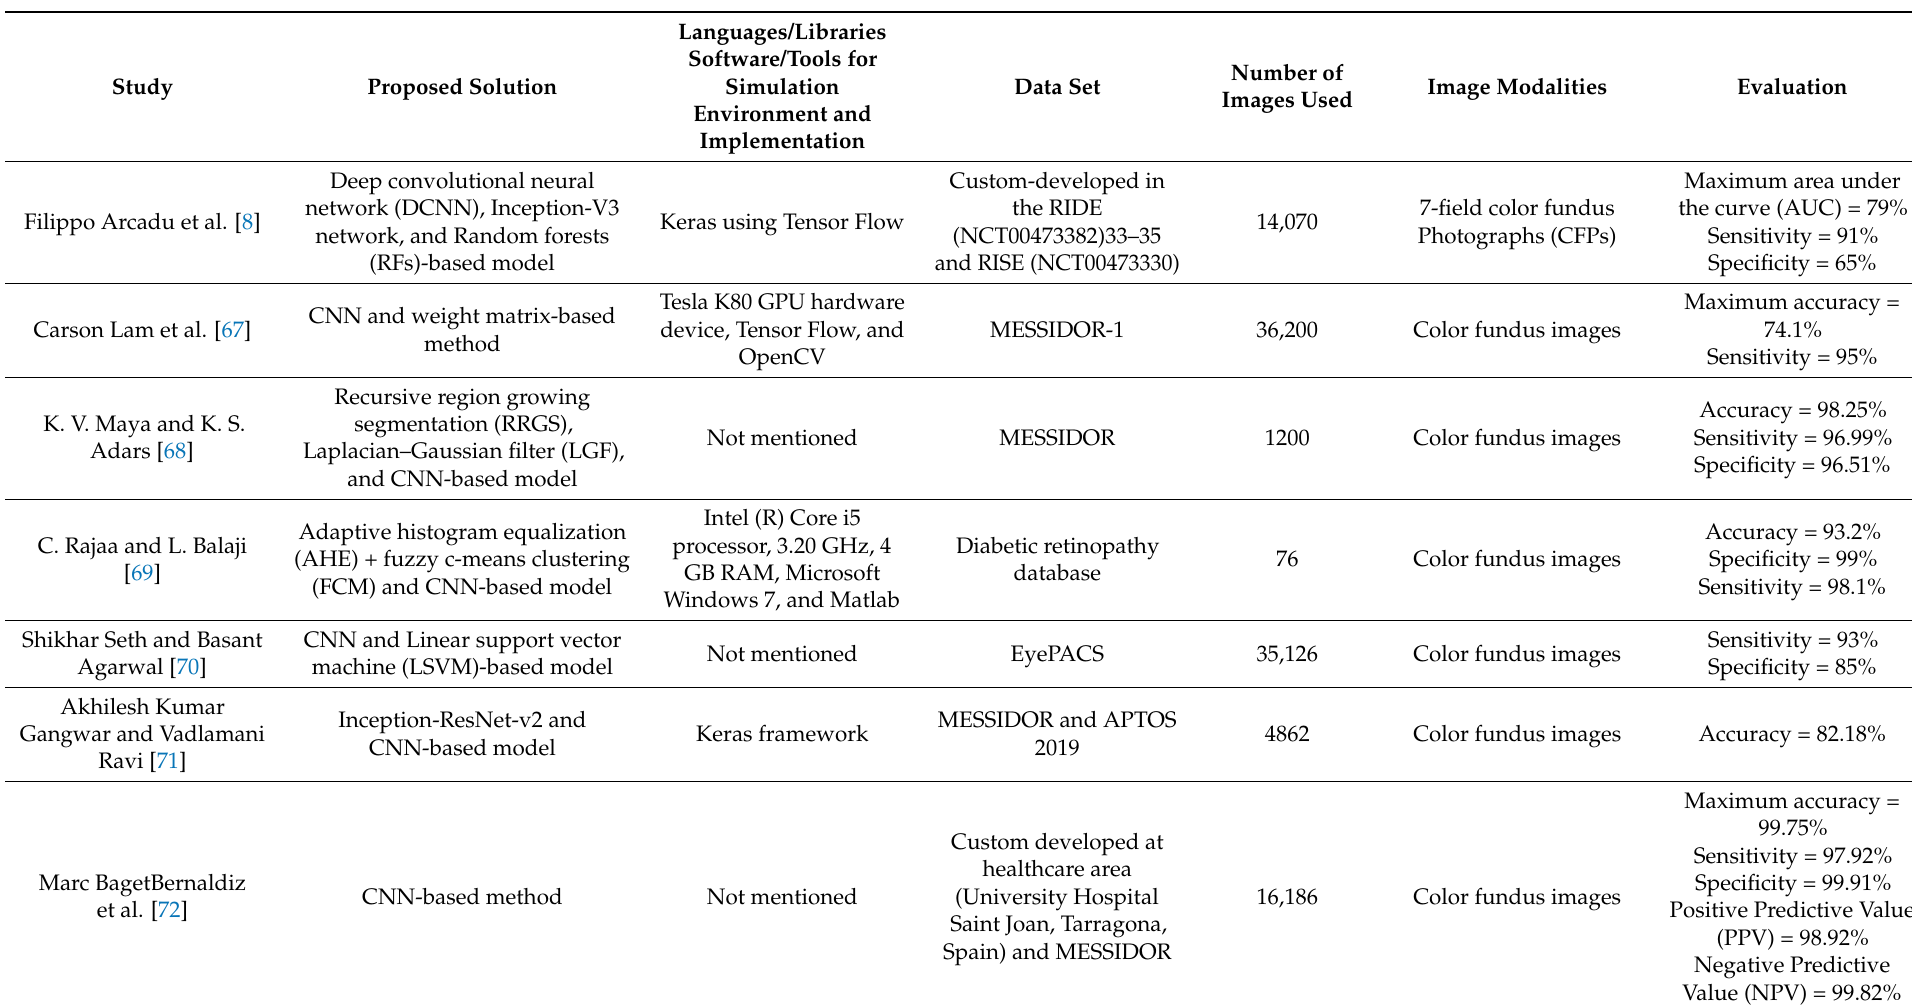
Table 3. Summary of reported techniques for lesion